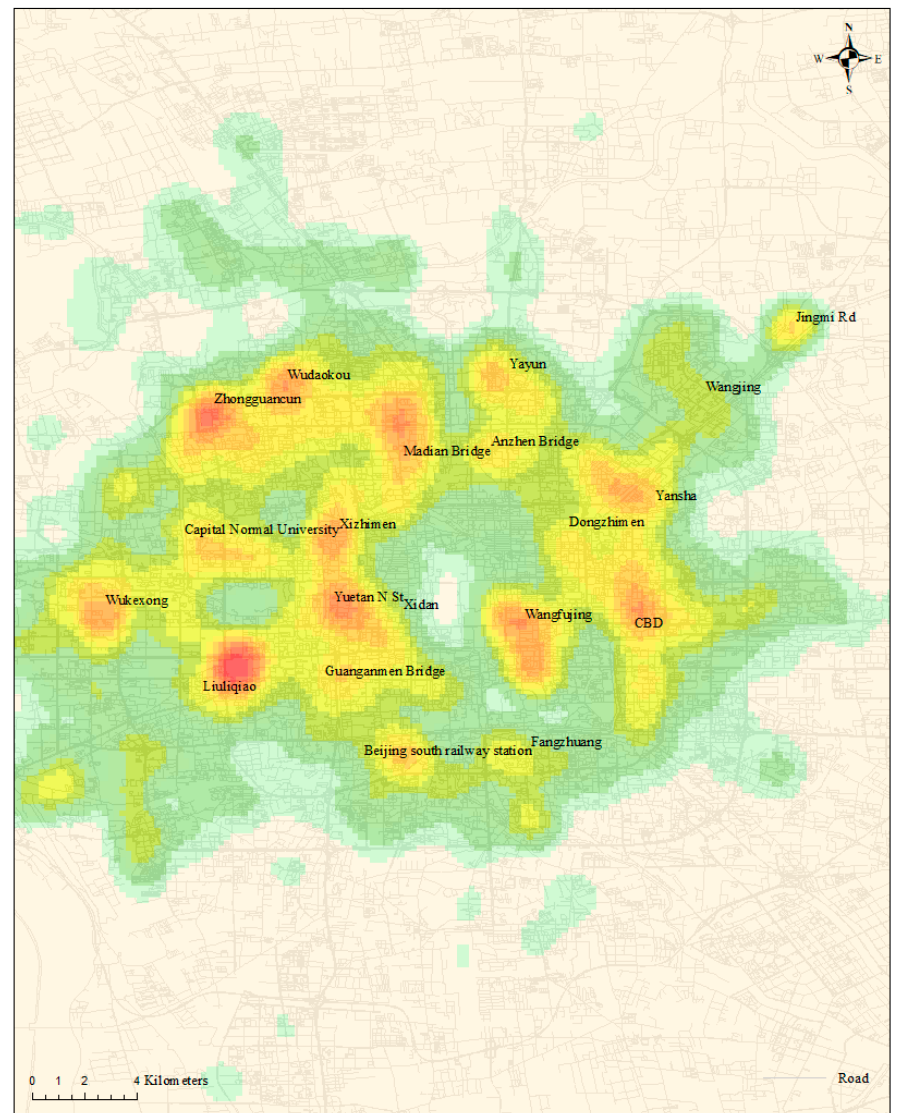
Figure 3. Kernel density estimation (KDE) map of taxi drop-off locations within five days in Beijing. 304 305